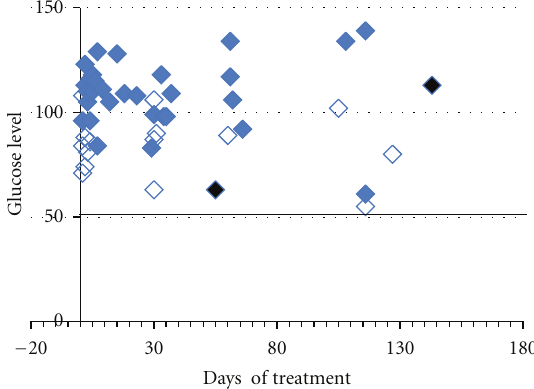
Figure 3: Glycemia values in Subject 1. Glucose blood levels were registered by the caregiver and recorded in the journal. The measurements were taken with a home device that the caregiver was trained to use on D0. On the X -axis are reported the days when the single measurements were taken, on the Y -axis are reported the glucose levels. For each measure the label shows the condition: blue filled diamond: full stomach, empty blue diamond fasting: and black filled diamond: vomit episode. The horizontal black line represents the threshold below which it was considered hypoglycaemia (glucose value 50).